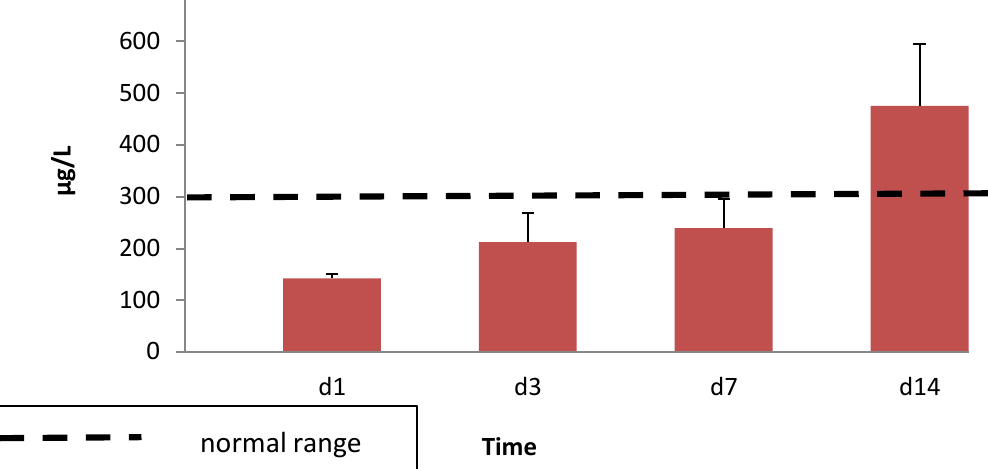
Figure 3. Serum transferrin and ferritin concentrations in 10 thermally injured patients. Data expressed as mean ± SE. Dotted lines denote the upper and lower normal